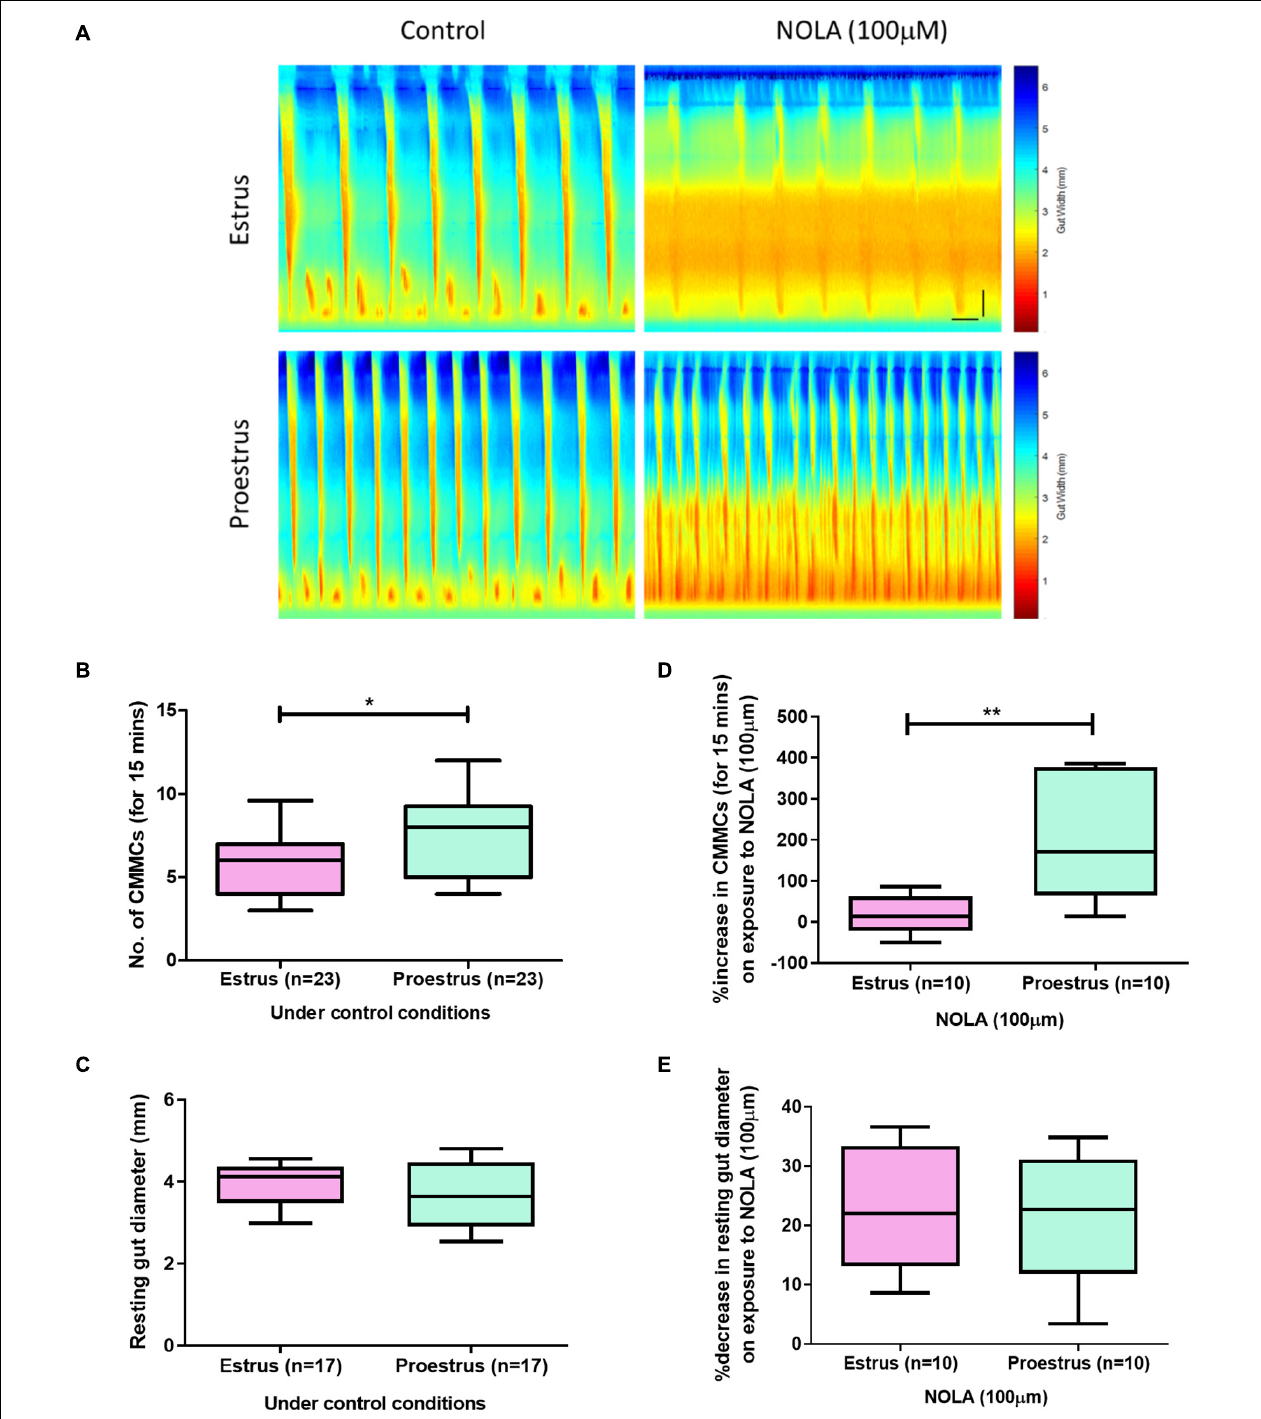
FIGURE 1 | (A) Spatiotemporal maps showing the number of CMCs during 15 min recordings of estrus and proestrus colon under the control conditions and on exposure to NOLA (100 µ M). (B) Females in estrus had fewer CMCs compared to proestrus ( n = 23, unpaired t -test, p = 0.042). (C) Resting colonic diameters were similar between the groups under control conditions. (D) Proestrus colons showed a larger percentage increase in the number of CMCs on exposure to NOLA compared to colons from mice during estrus ( n = 10, unpaired t -test, p = 0.003). (E) NOLA similarly decreased resting gut diameter in both estrus and proestrus groups ( n = 10, unpaired t -test, p = 0.97). Horizontal scale bar = 60 s, vertical scale bar = 0.5 cm. ** p < 0.01 and * p <